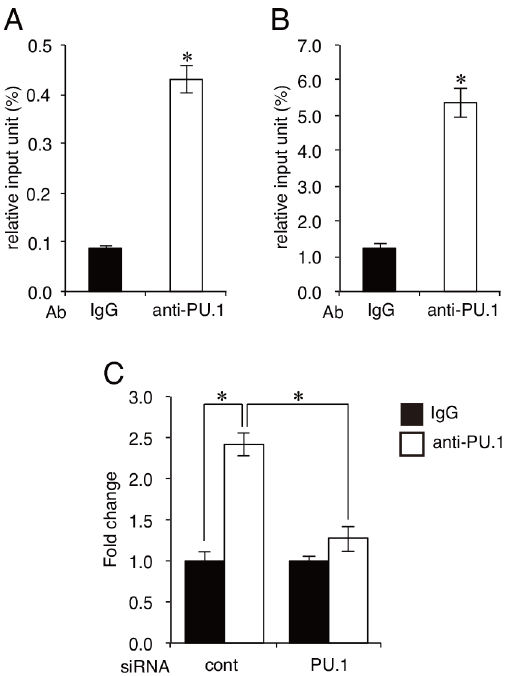
Fig 2. Quantitative analysis of PU.1 binding to the pIII in CAL-1 and murine splenic pDCs. A and B. The amount of chromosomal DNA immunprecipitated with anti-PU.1 Ab (open bar, anti-PU.1) or control IgG Ab (closed bar, IgG) in CAL-1 cells (A) and murine splenic pDCs (B). Binding degree is expressed as a percentage of the input for each ChIP assay. C. The amount of PU.1 binding to the pIII in PU.1 siRNA- introduced CAL-1 cells (PU.1) or control siRNA-introduced cells (cont.). Cells were harvested at 48h after siRNA transfection. Binding level of PU.1 (open bar) is expressed as fold change against that of control IgG (closed bar). Data represent means ± SEMs of three independent experiments. Each experiment was performed with duplicate samples. * , p < 0.05.